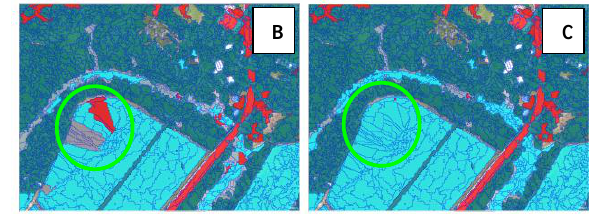
Figure 6. Water classification using assign class algorithm with mean CHM maximum threshold value of 0.2 and a 2nd condition of relative border to Water of 0.15.